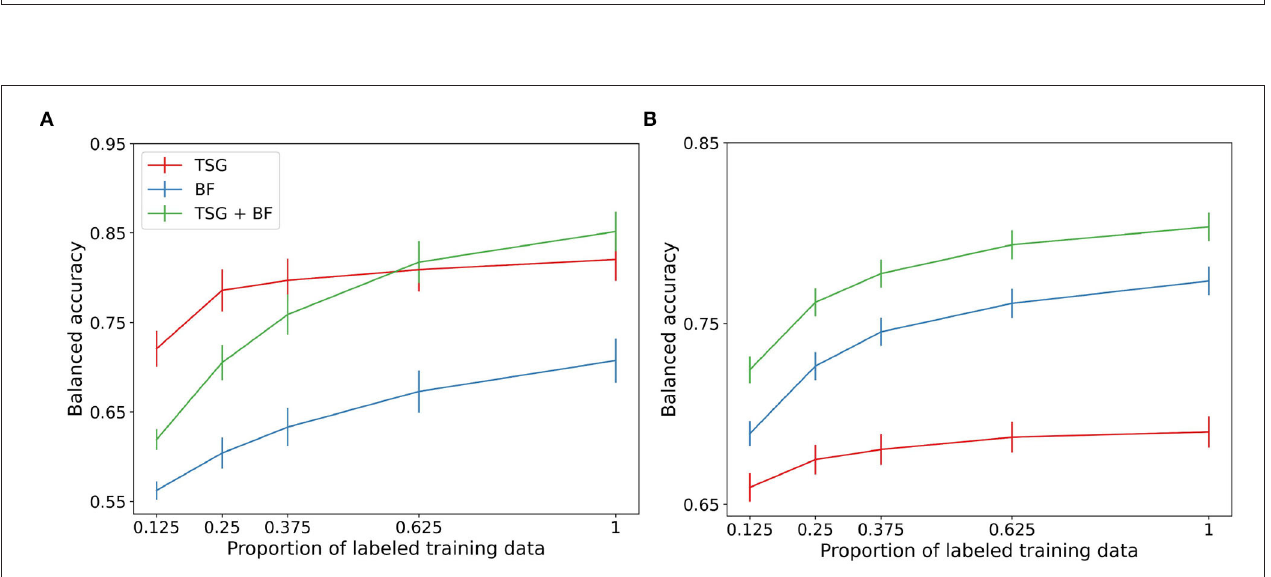
FIGURE 3 | Non-constant querying (semi-supervised) classification results. (A) Mental math. (B) MATB-II.